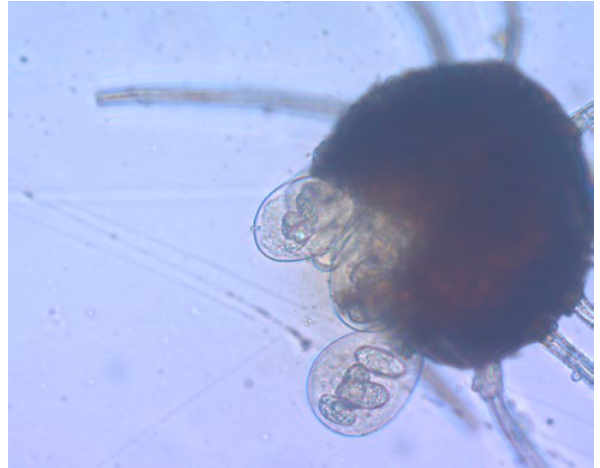
Figure 6. Chasmothecium of Erysiphe elevata containing asci with ascospores.